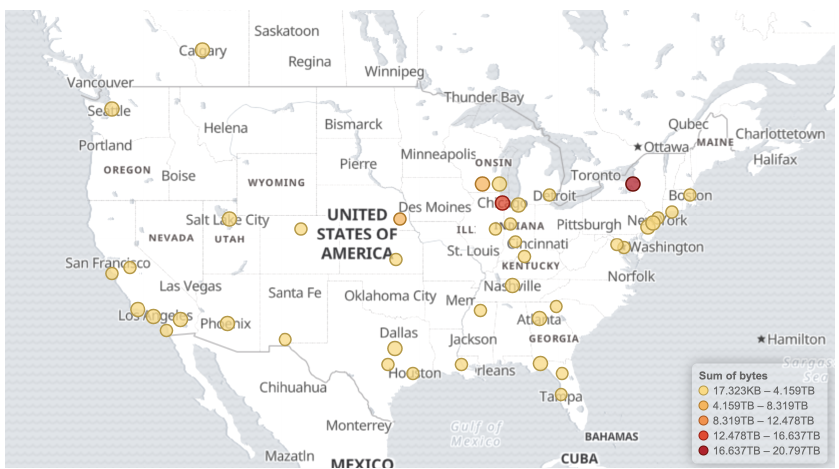
Figure 3: Map of destination by bytes transferred to